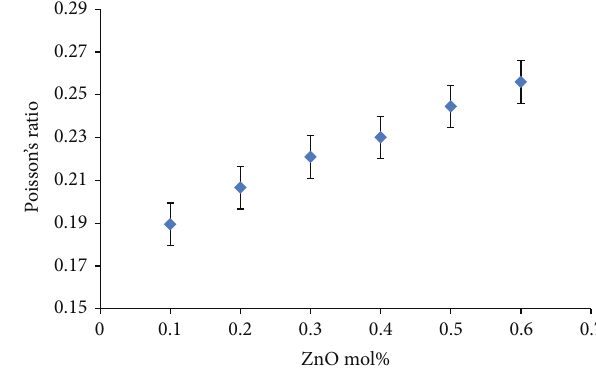
Figure 3: Variation of sound velocity versus ZnO mol%.